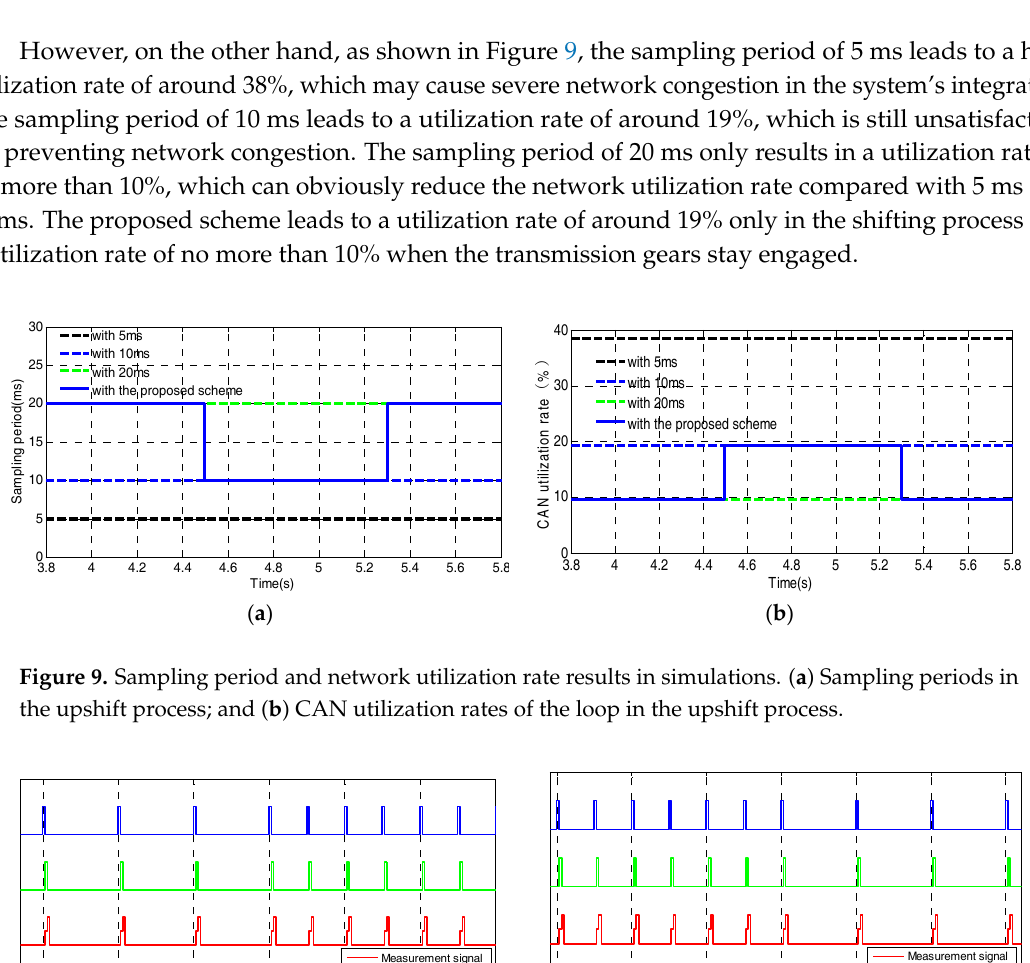
Figure 10. Communication behaviors of the messages in the loop in simulations. ( a ) The period varies when the shifting is active; and ( b ) The period varies when the shifting is over.